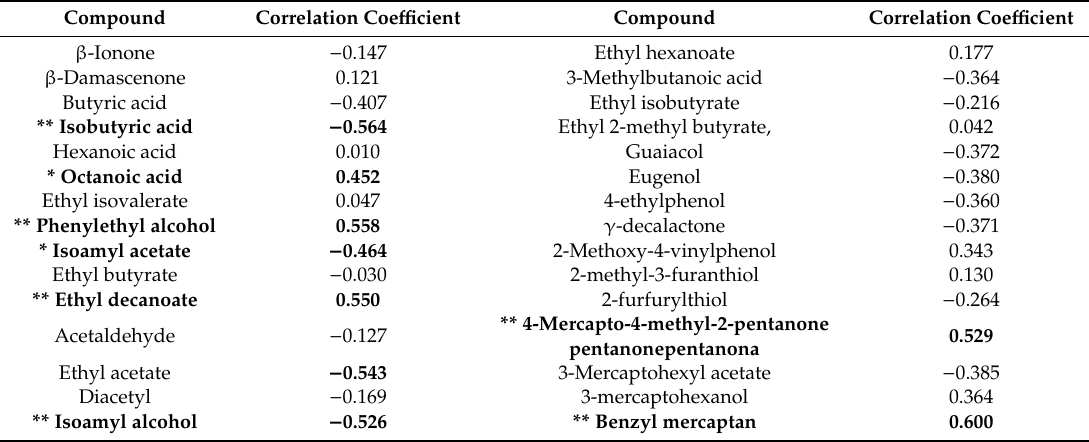
Table 2. Chemical compounds with correlation at a confidence level of 90% with the olfactory